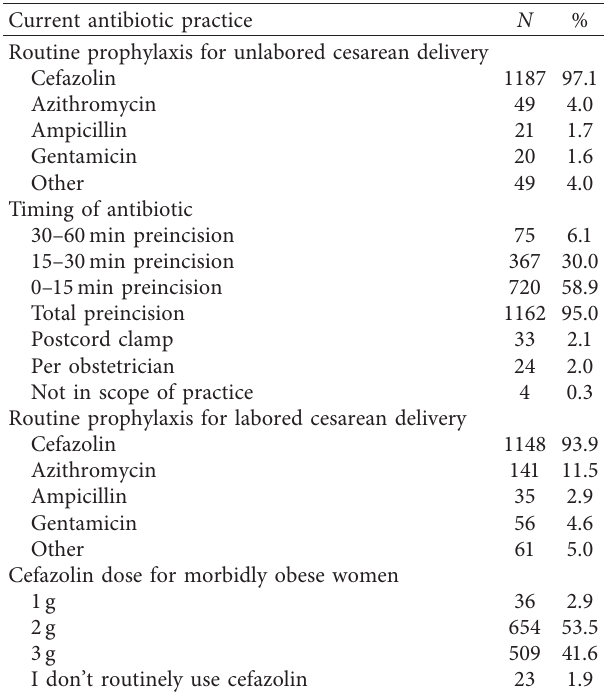
Table 2: Current antibiotic practices by anesthesiologists for ce- sarean delivery.